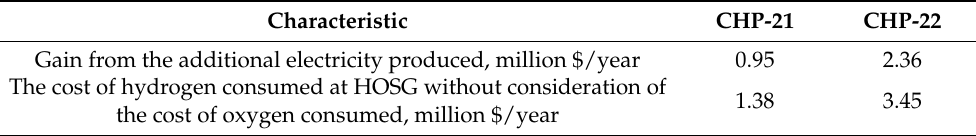
Table 7. Annual fuel costs for HOSG and the gain from the additional electricity produced at CHP-21 and